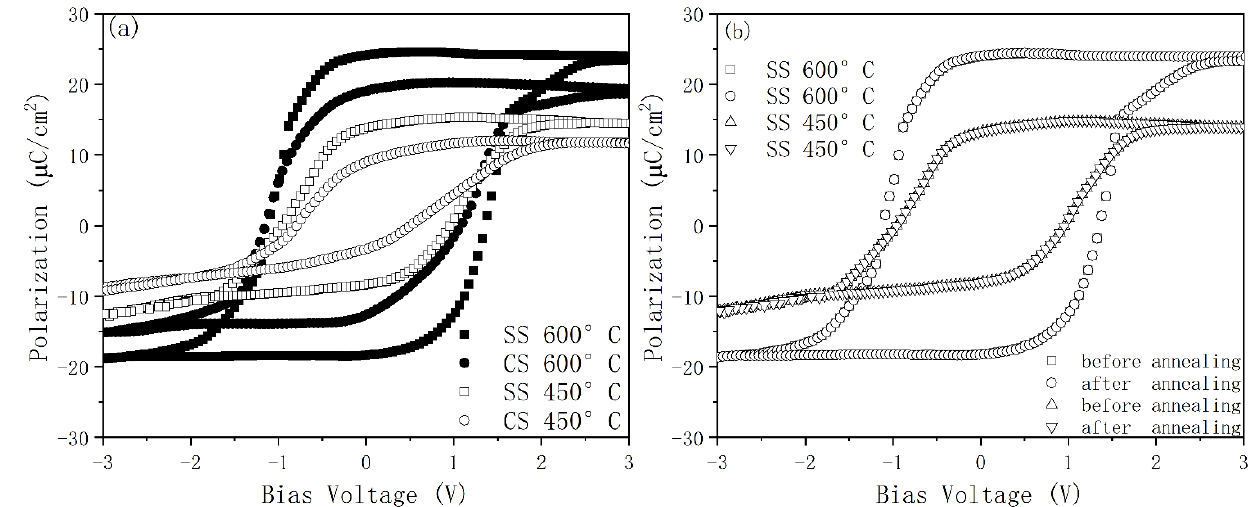
Figure 1. ( a ) Typical polarization vs. bias curves of SS samples under various RTP temperatures in comparison to control samples (CS). ( b ) After two hours of annealing in oxygen, there was no weakening or disappearance of ferroelectric characteristics after the ferroelectric phase had formed.